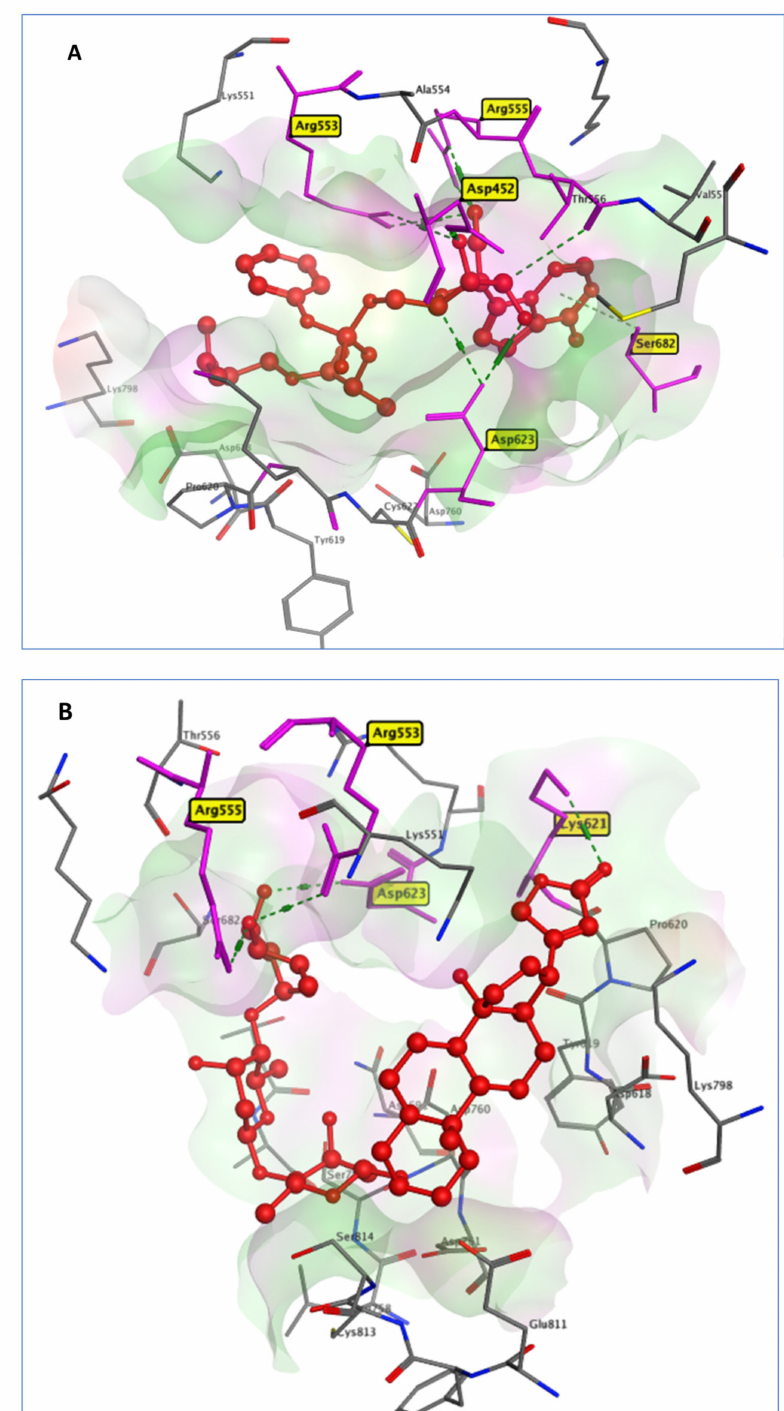
Figure 5. 3D interactions between RDV ( A ) and DIG ( B ) with 7BV2 active site